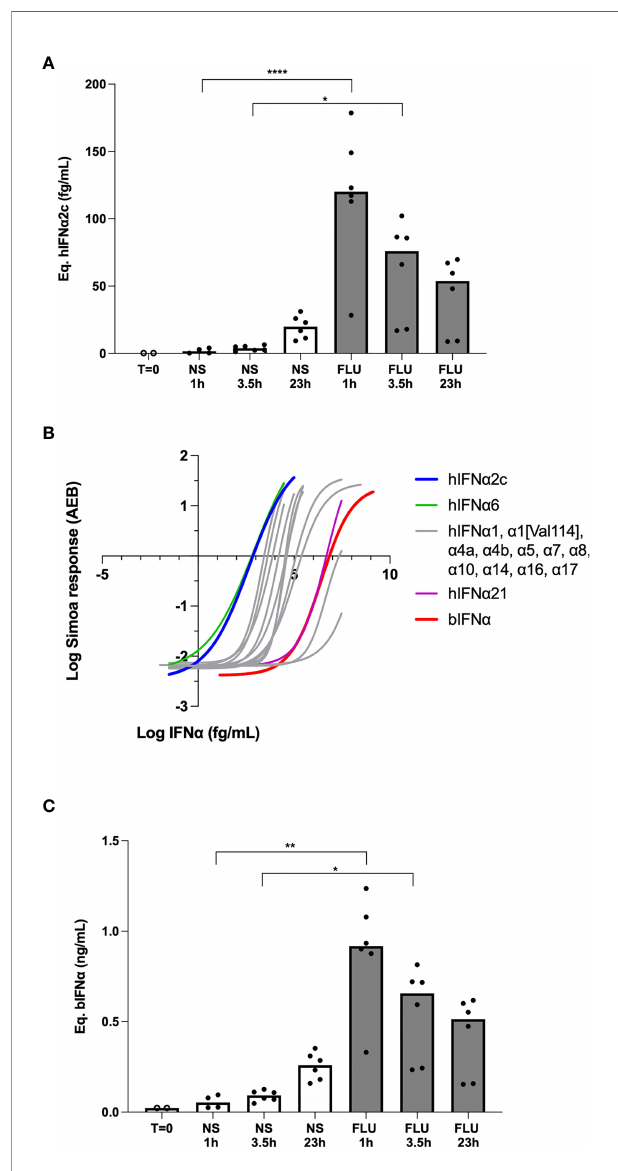
FIGURE 1 | Bat IFN a proteins are detected with a human IFN a 2 digital ELISA assay. (A) IFN a protein levels expressed as equivalent human IFN a 2c concentrations obtained after stimulation of bat epithelial cells Tb 1 Lu with 500HAU/mL mouse in fl uenza virus (FLU) or unstimulated (NS) for 0 to 24 hours at 37°C and 5% CO 2 . (B) hIFN a 2 digital ELISA assay response (AEB) as a function of the IFN a concentration for the Rousettus aegyptiacus IFN a calibrator (bIFN a ) produced in Escherichia coli (red) in comparison with the human IFN a 2c calibrator (blue) and the 12 other human IFN a subtypes. (C) IFN a protein levels expressed as equivalent bIFN a concentrations obtained after stimulation of bat epithelial cells as described previously. Box plots represent median and individual values represented by dots are reported on fi gures, (A, C) representing pooled results from 3 independent experiments. Kruskal – Wallis test with Dunn ’ s post testing for multiple comparisons was used, *p < 0.05, **p < 0.01, ****p <